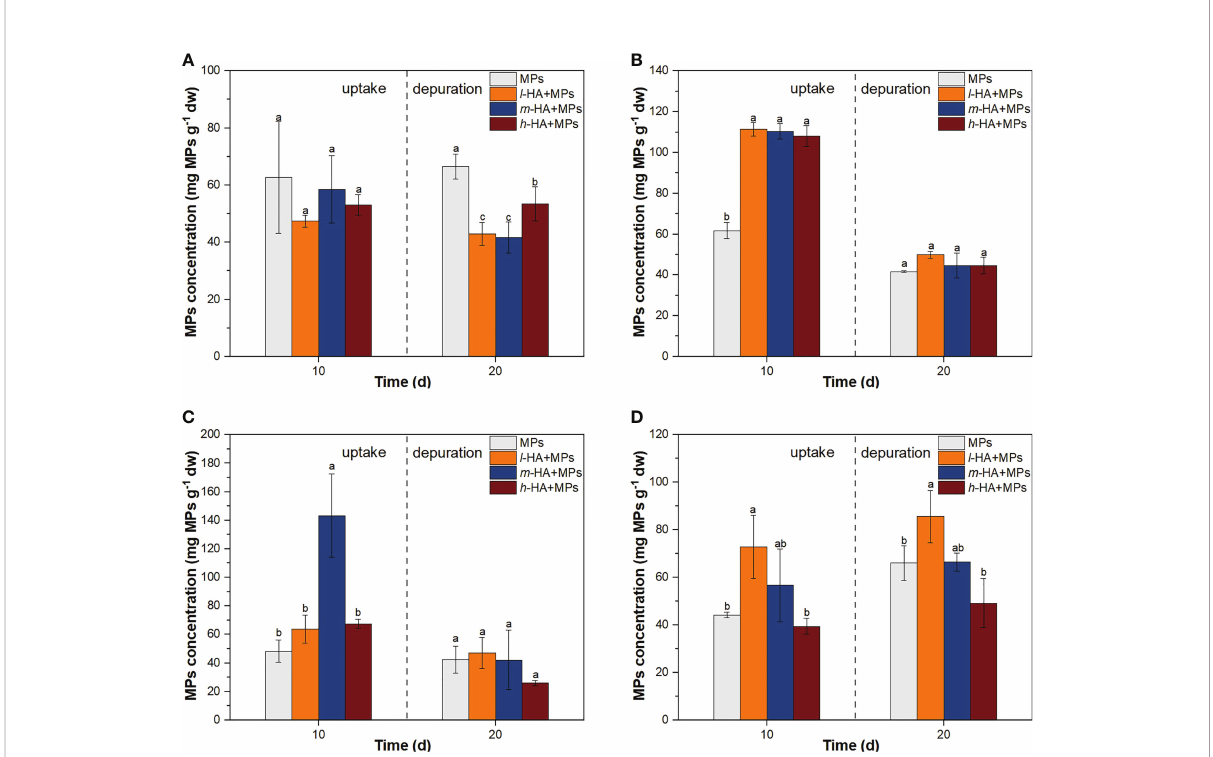
FIGURE 4 The accumulation of MPs in fi sh gill (A) , gut (B) , liver (C) , and brain (D) following the treatments of MPs with different HA fractions over 10-day exposure and 10-day depuration. Error bars indicate ± SD (n=3). The different lowercase letter indicate signi fi cant differences among different sampling times in each treatment (p<0.05).